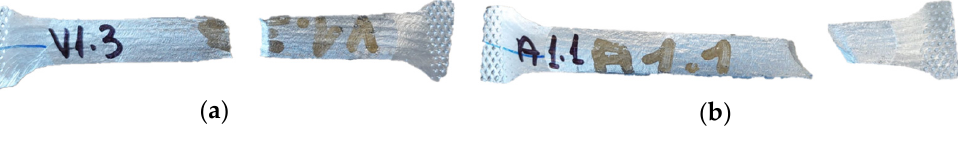
Figure 8. Specimens after tensile testing: ( a ) V1.3; ( b ) A1.1.